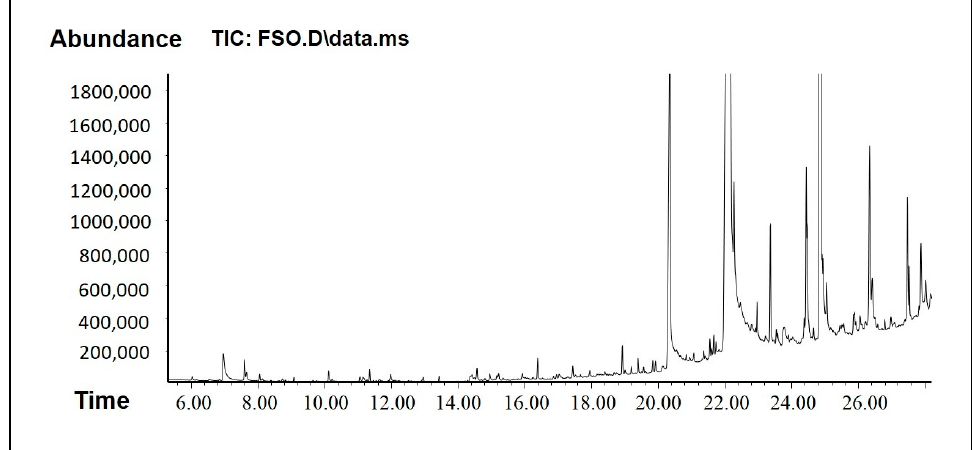
Figure 3. GCMS chromatogram of